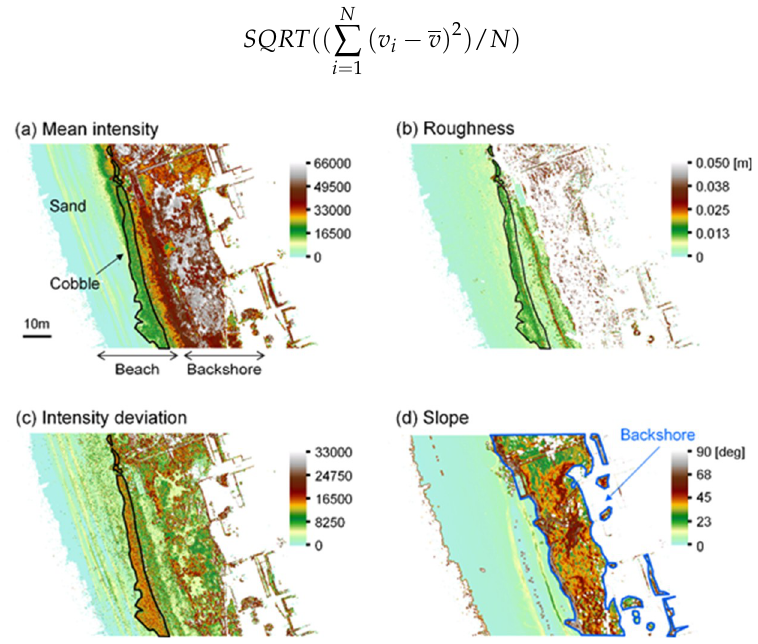
Figure 3. Rasters (20 cm resolution, location shown in Figure 2) of ( a ) mean intensity, ( b ) roughness, ( c ) intensity deviation, and ( d ) slope. Black and blue lines show manually delineated cobble and backshore areas, respectively.